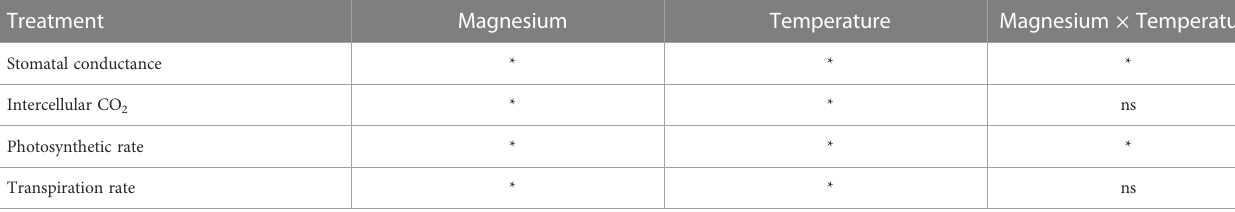
TABLE 3 Results of Two-way ANOVAs on tobacco gas exchange parameters.